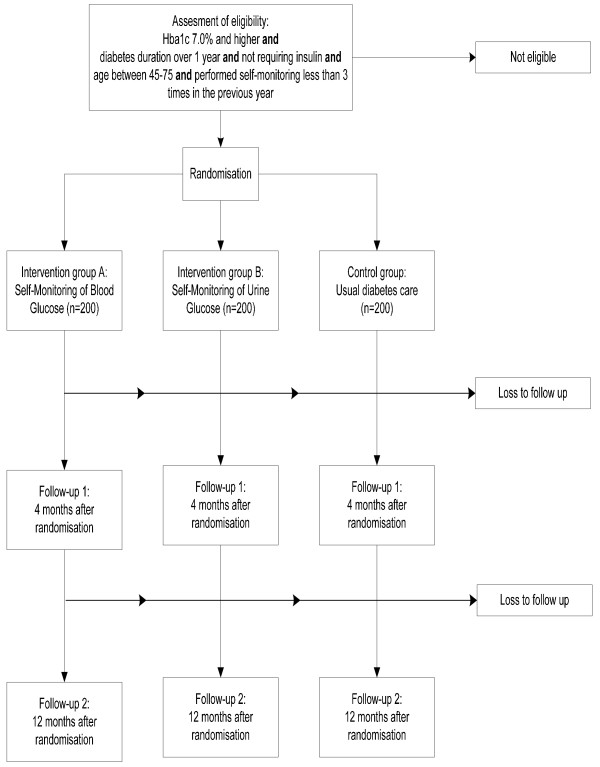
Design of the RCT.